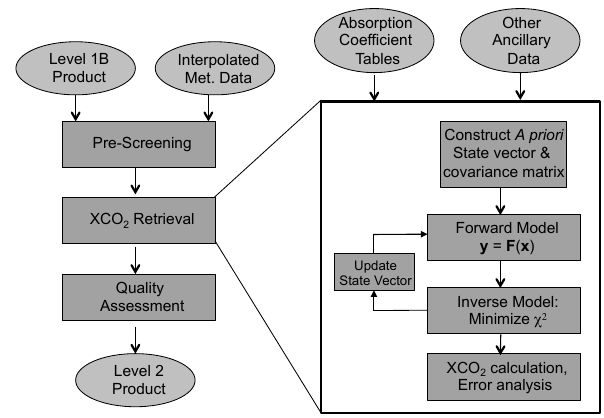
Fig. 1. Flowchart showing the basic steps for the end-to-end ACOS Level-2